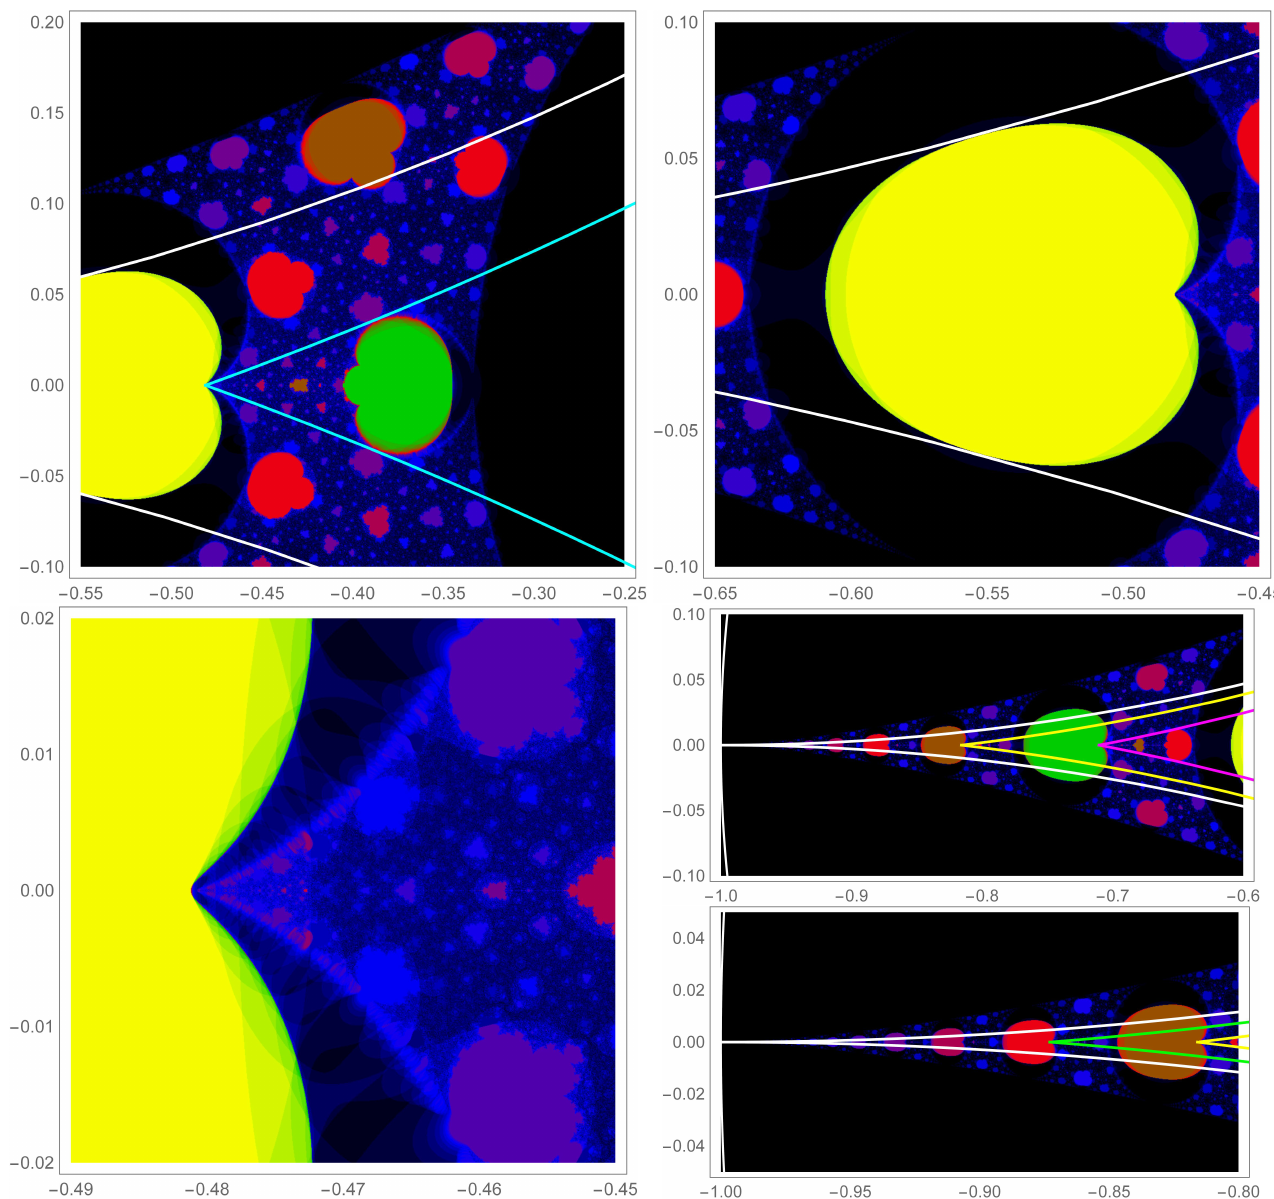
Figure 3. Several blow-ups on one of three arms of the j -averaged Mandelbrot set in Figure 2. The top two panels reveal the tangency to the geodesics of the ideal regular triangle shown in white in Figure 2 and the cyan-colored hyperbolic triangle formed from the clefts of the yellow domains. The bottom left panel shows a blow-up of the cleft region of the yellow domain. The j -averaged Mandelbrot set is quite active in the region emerging from the nexus of the cleft. The bottom right panel shows two sequential blow-ups of the tail of the arm of the j -averaged Mandelbrot